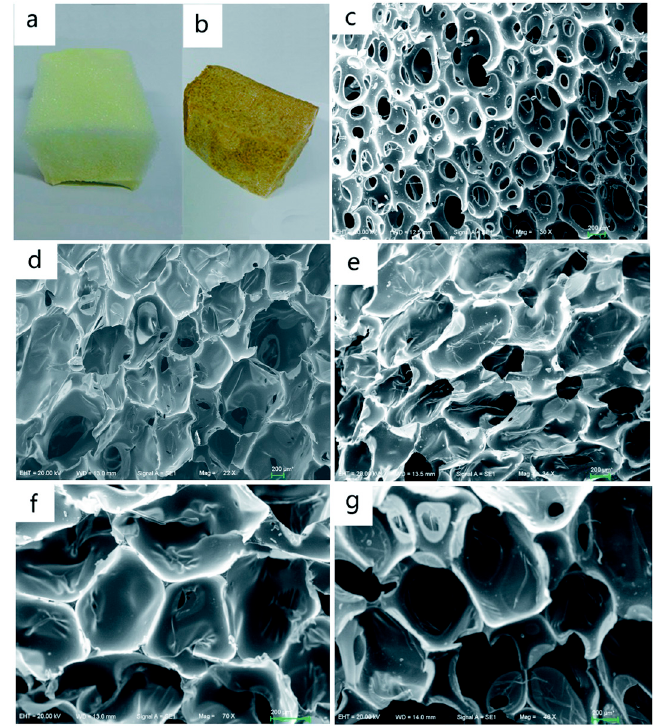
Figure 17. The digital photograph of the synthesized polyurethane foam ( a ) and MWPU foam ( b ); SEM photographs of the surface of the PU foam (P6) ( c ) and pine wood-based MWPU foams with different content of MP fillers: 0 wt% ( d ), 5 wt% ( e ) 7.5 wt% ( f ), 10 wt% ( g ) [100] .